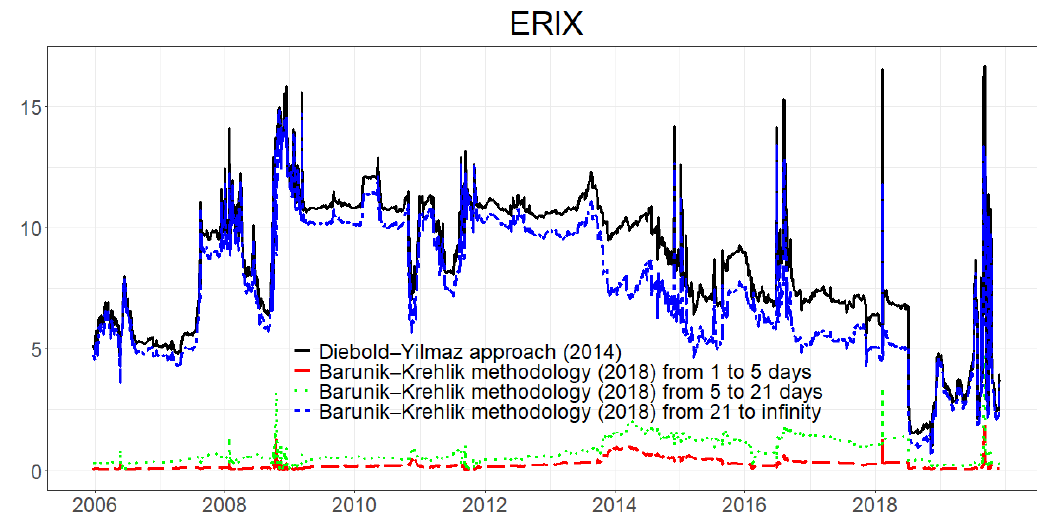
Figure 6. Diebold–Yilmaz [15] directional volatility spillover (from) and Barunik and Krehlik [16] directional volatility spillover (from) in Europe. Note: ERIX indicates European Renewable Energy Index.